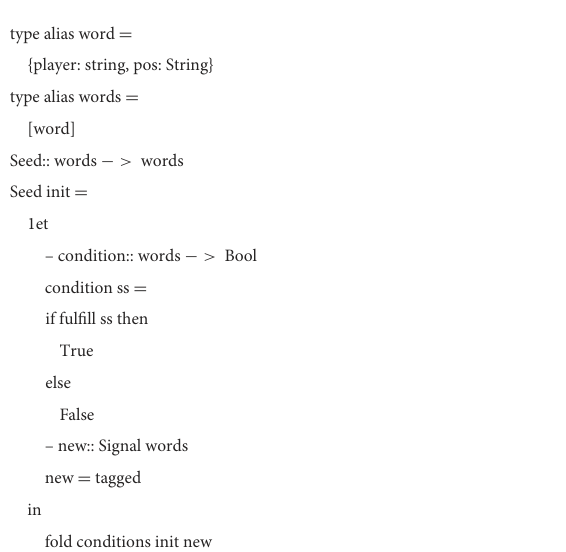
TABLE 1 Initiation rules modeling method process. TABLE 2 Marking operation of the